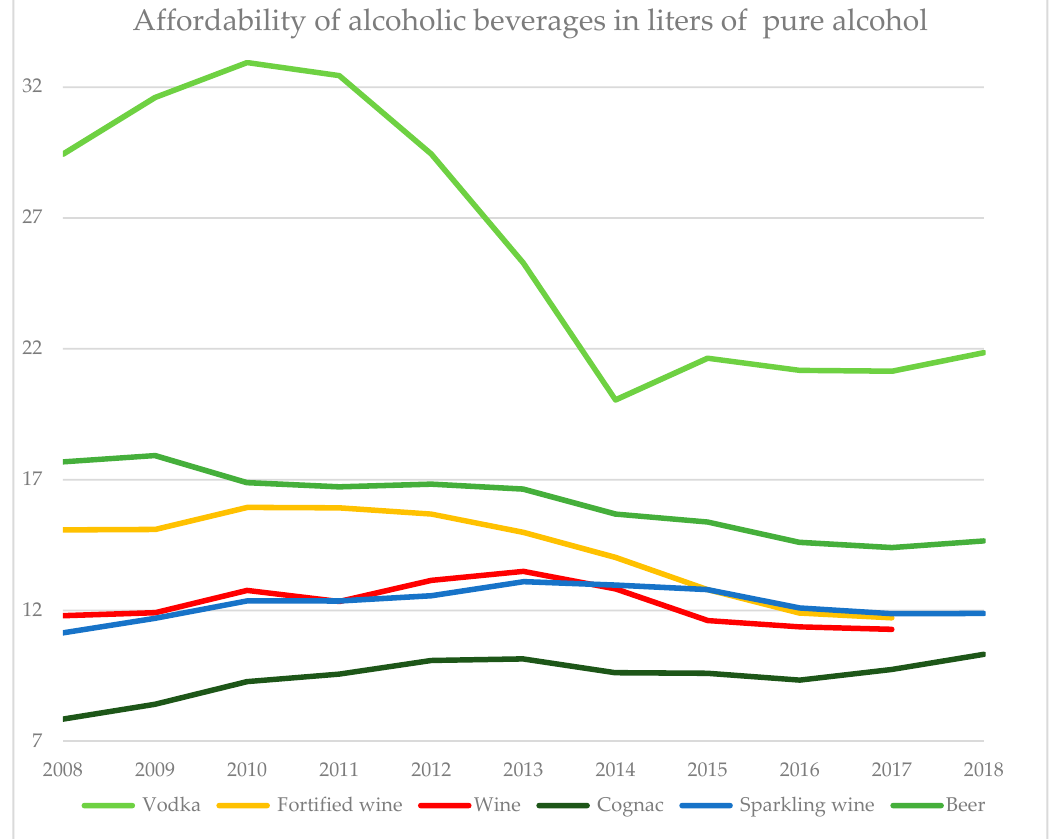
Figure 3. Affordability of alcoholic beverages, defined as how much of a specific beverage could be afforded with a Russian per capita income in a given year, calculated for pure liters of alcohol of each beverage. For wine and fortified wine, no data was available for 2018. Sources: Federal State Statistics Service.